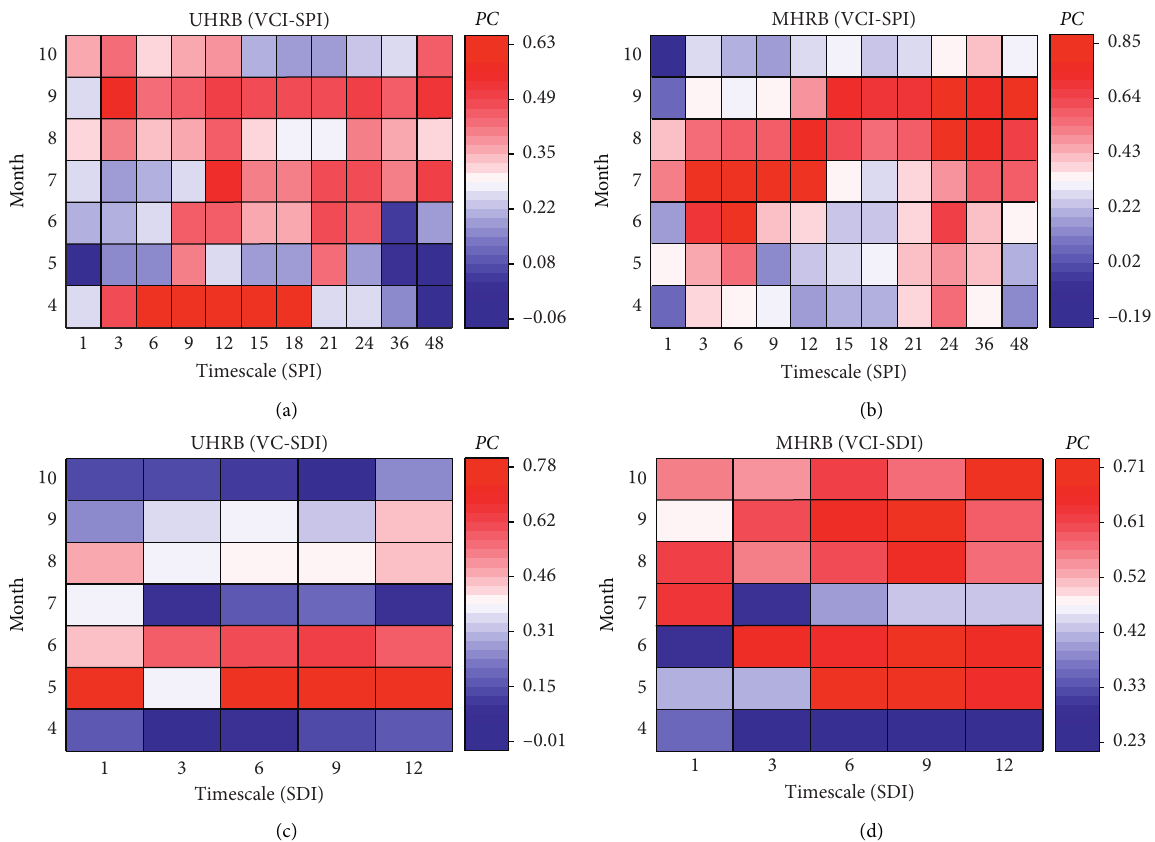
Figure 12: Heat map showing growing season Pearson’s correlation coefficients between VCI and different timescale of SPI, VCI, and different timescale of SDI for the period of 1999–2012 in the UHRB (Ylx). (a) (PC ≥ 0.53, p < 0.05), (b) (PC ≥ 0.55 or ≤ − 0.69, p < 0.01) and MHRB (Zyx), (c) (PC ≥ 0.55, p < 0.05), and (d) (PC ≥ 0.54, p < 0.05).